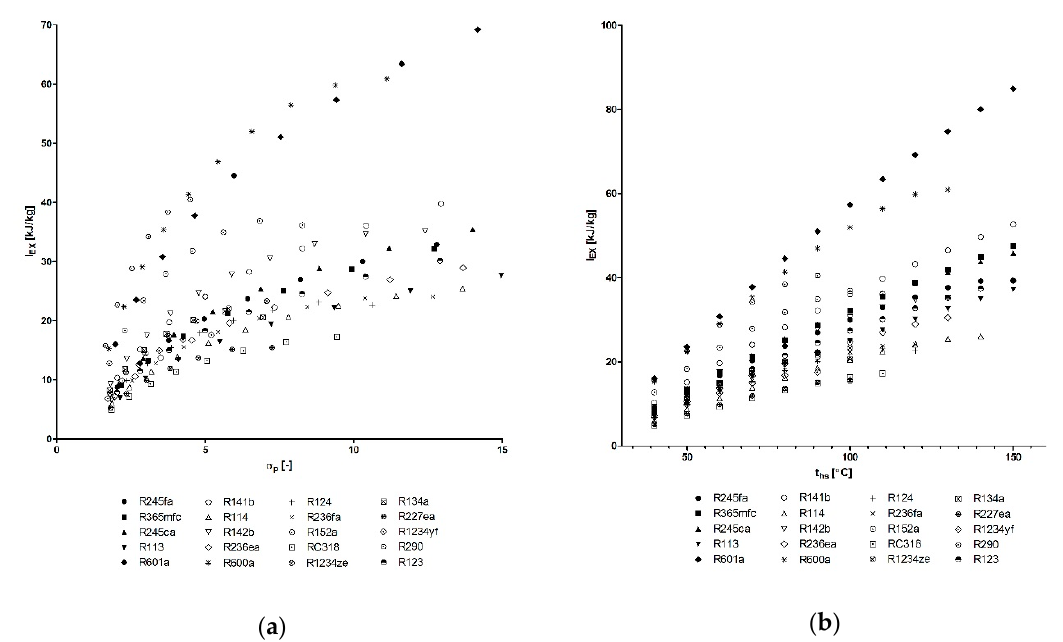
Figure 10. The variation of isentropic expansion work vs. pressure expansion ratio and heat source temperature: ( a ) l ex = f( σ P ); ( b ) l ex = f(t hs ).